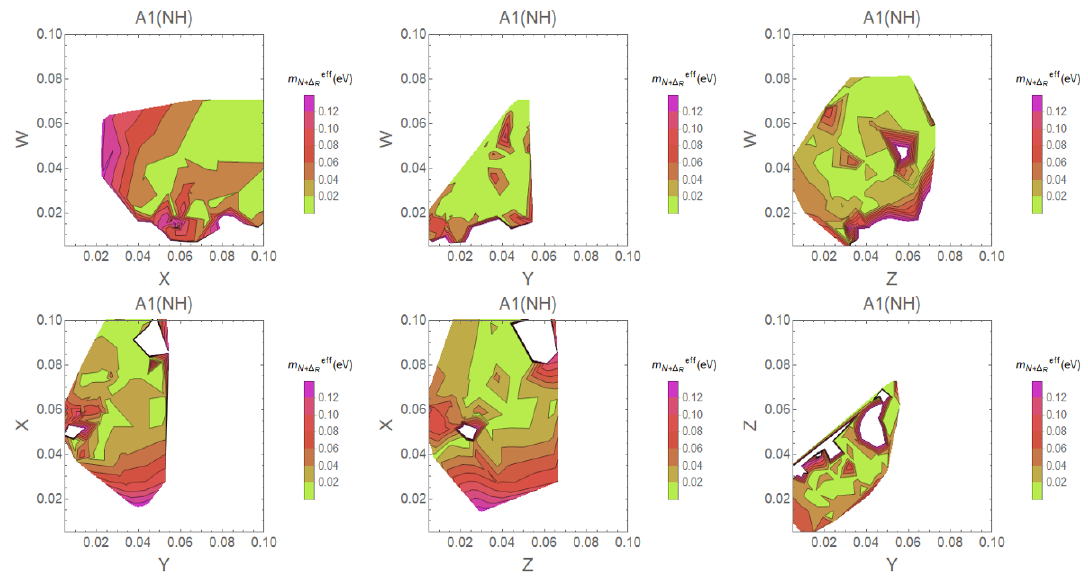
JHEP02(2019)129 Figure 8 . The various combinations of type II SS model parameters (in eV) with the new physics contribution to e(cid:11)ective mass as the contour, where 0.061 eV is the KamLAND-Zen upper limit in A1 class of two texture zero neutrino mass matrix for normal hierarchy. Figure 9 . The various combinations of type II SS model parameters (in eV) with the new physics contribution to e(cid:11)ective mass as the contour, where 0.061 eV is the KamLAND-Zen upper limit in A1 class of two texture zero neutrino mass matrix for inverted hierarchy. { 20